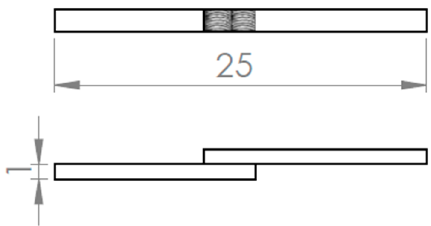
Figure 7. Illustration of the sample for microstructural observation.